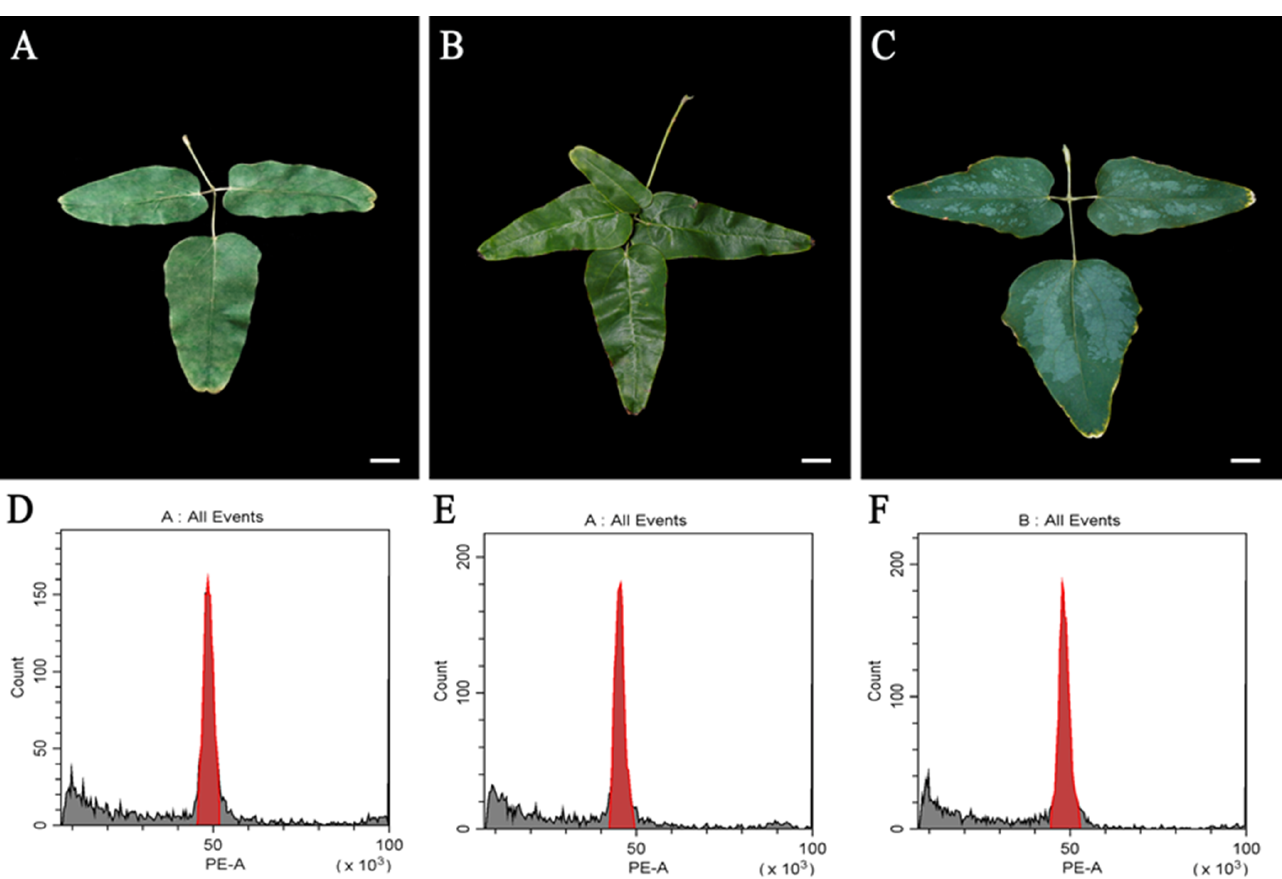
Figure 4. Leaf morphology and flow cytometry analysis of the three types of plants regenerated from the immature seeds of wild A. trifoliate . ( A , D ) Normal type: the plants showing a similar leaf phenotype to the wild plant. ( B , E ) Type Ι : each compound leaf having 4 leaflets. ( C , F ) Type ΙΙ : the leaves exhibiting large white blotches. Bars = 5 cm.